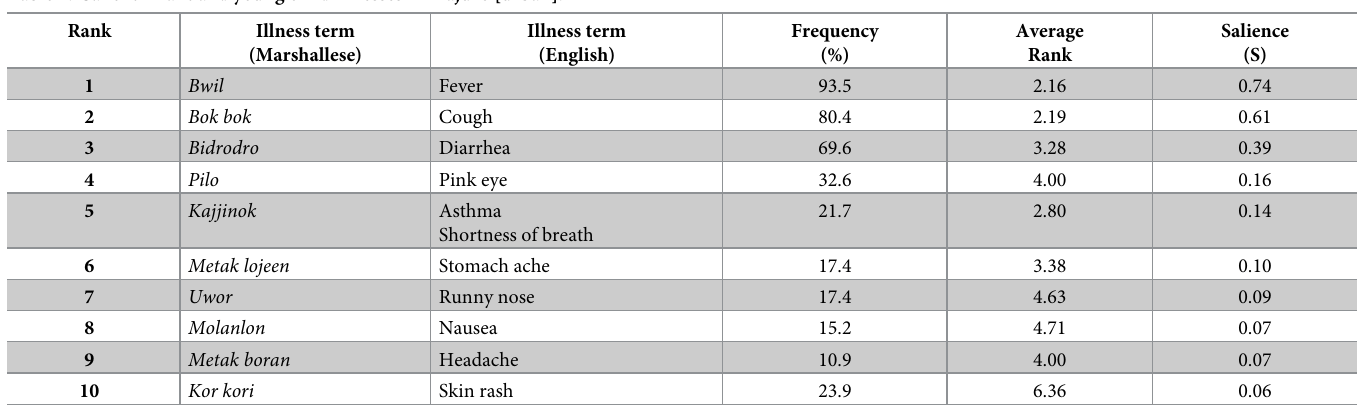
Table 4. Salient infant and young child illnesses in Majuro [urban].